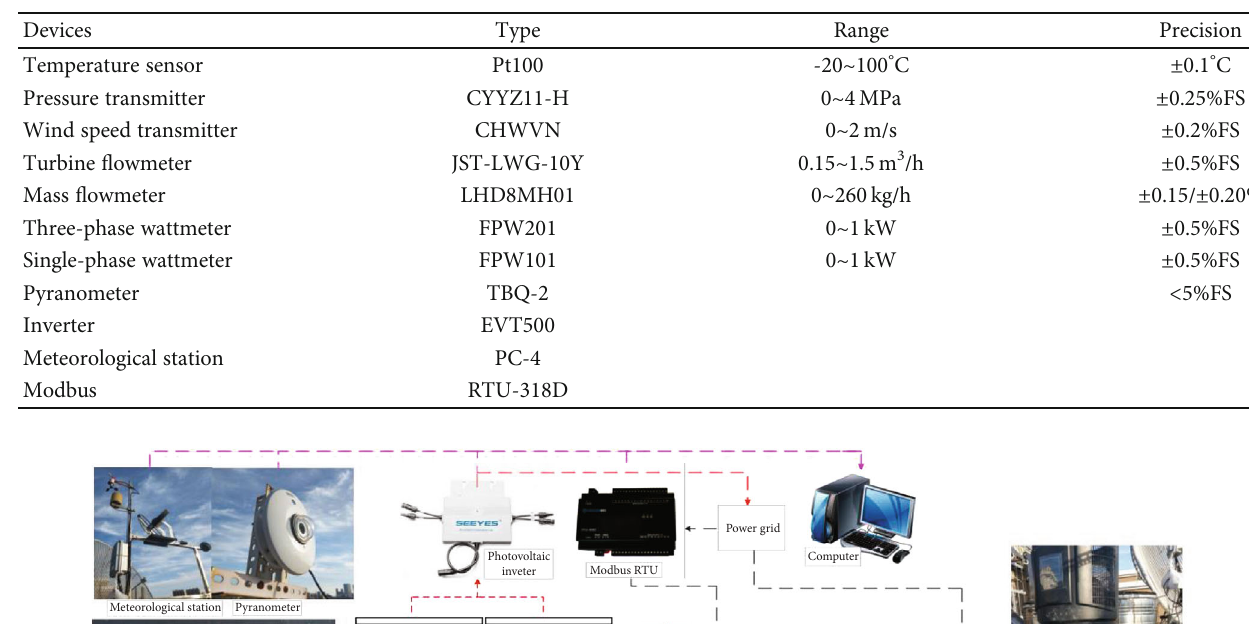
Table 1: Experimental devices used in the experiment.